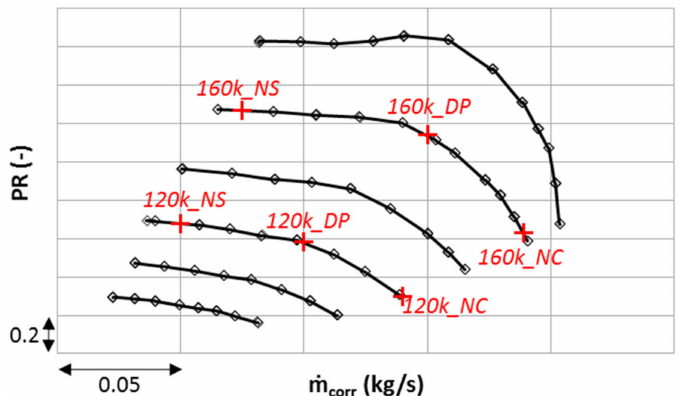
Figure 3. Base compressor map highlighting key operating points of interest. (Reproduced with permission from Taylor & Francis Group, ©2021